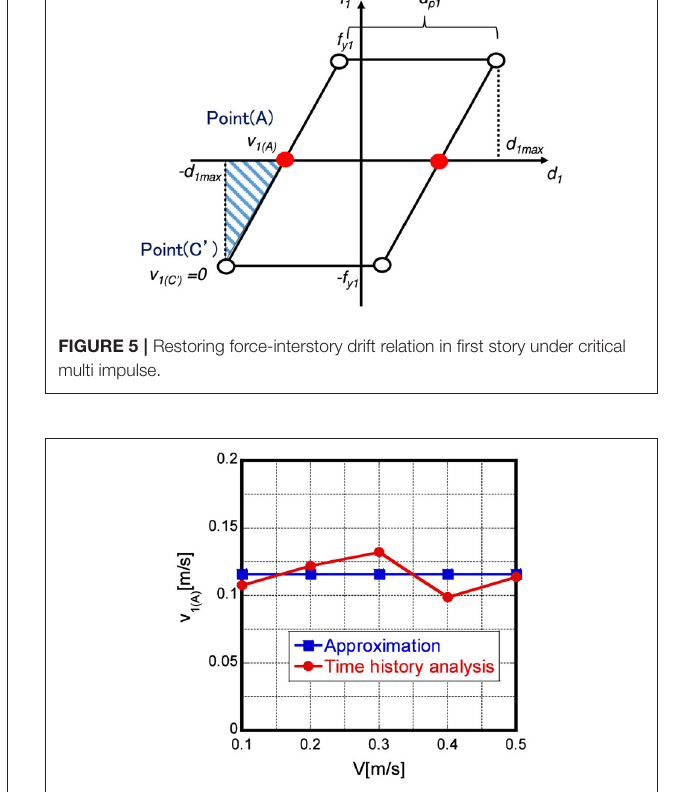
FIGURE 6 | Comparison of velocity v 1(A) of first-story mass at Point (A) derived from Approximation (a) and that obtained by time-history response